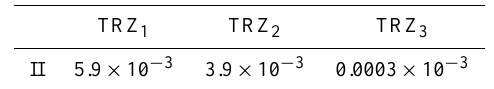
Table 1. Mean of the posterior probability × yr − 1 in the TRZ i (i = 1 , 2 , 3 )